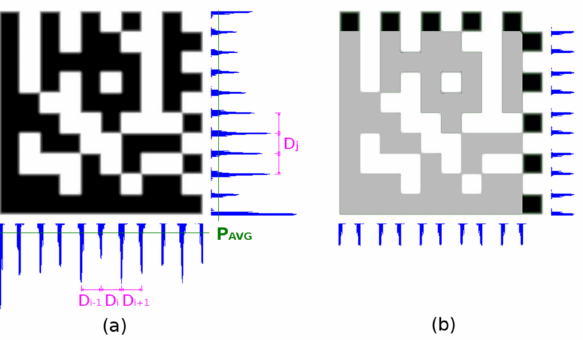
Figure 17. Horizontal and vertical edge projections of the Data Matrix code. ( a ) projections of the whole area; ( b ) projections of the Timing